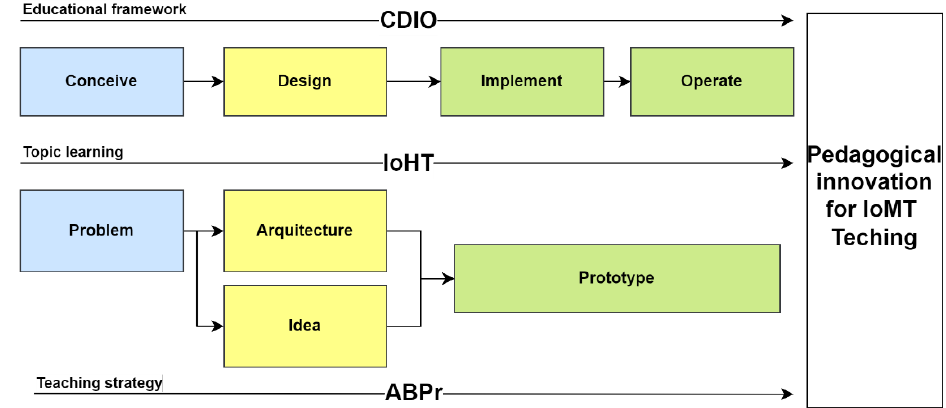
Figure 2. Educational strategies for learning the Internet of Things.